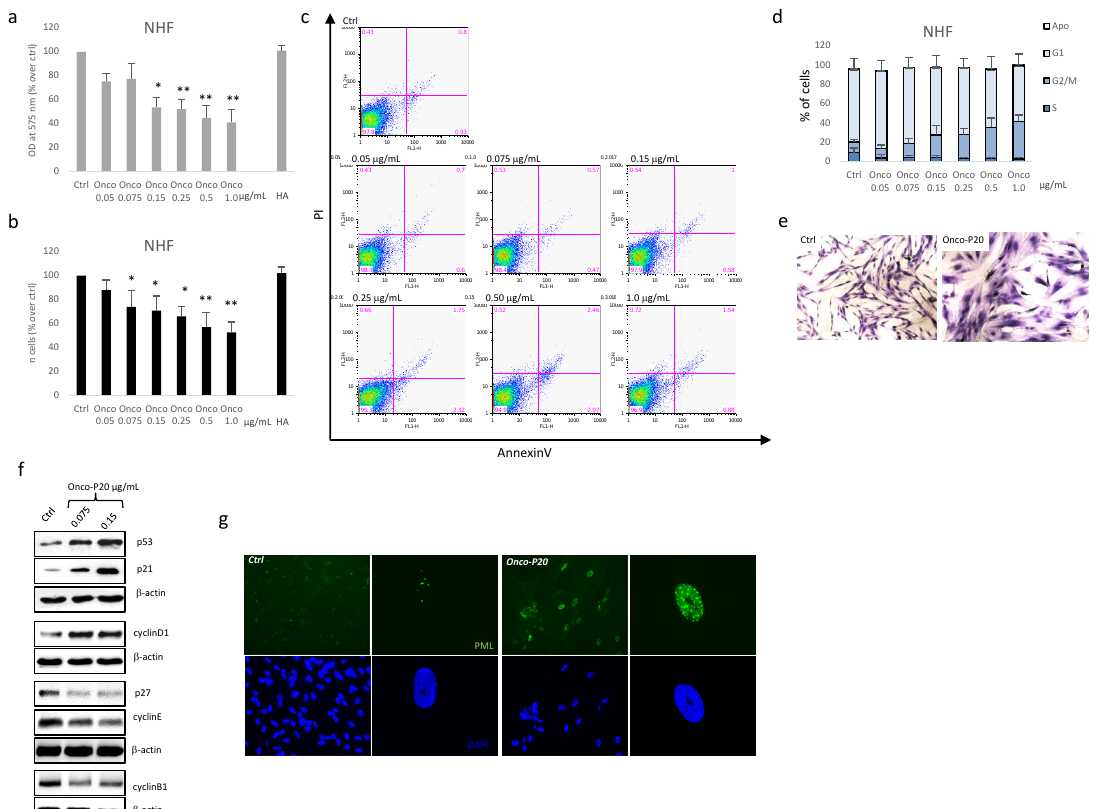
Figure 4. ( a ) MTT assay and cell count ( b ) of several different NHF cell lines treated (72 h) with increasing concentrations of Onco-P20 (range 0.05–1.0 µ g/mL) or HA 1.0 µ g/mL, equivalent to the HA concentration at the Onco-P20 higher doses. ( c ) FACS analysis using AnnexinV/iodide propidium staining excluded apoptosis. Dot plots show one representative experiment performed 24 h after Onco-P20 treatment. ( d ) Histograms show the mean ± SD of six independent experiments performed with cells isolated from six different donors. ( e ) Representative images of Coomassie staining of fibroblasts after Onco-P20 treatment for 14 days and of control active proliferating cells. Original magnification 20 × . Statistical significance versus the untreated control is reported as * p < 0.05 and ** p < 0.001. ( f ) Western blot analysis of cell cycle progression regulators. ( g ) Immunofluorescence analysis of PML expression and of PML nuclear body organization. Nuclei were stained with DAPI. Original magnification of 20 × and 63 × for greater